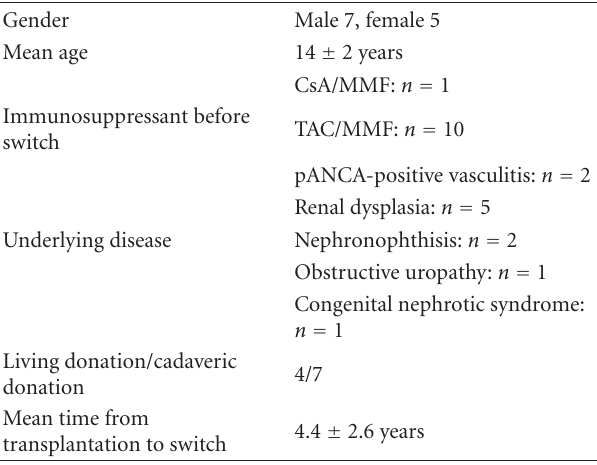
Table 1: Patient